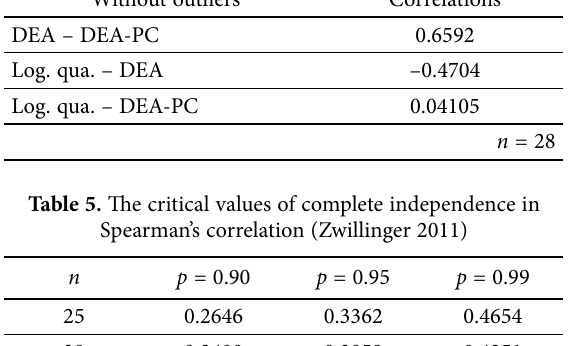
Table 4. Correlation between the rankings in case A 1, without the outlier ( source : own research) Without outliers